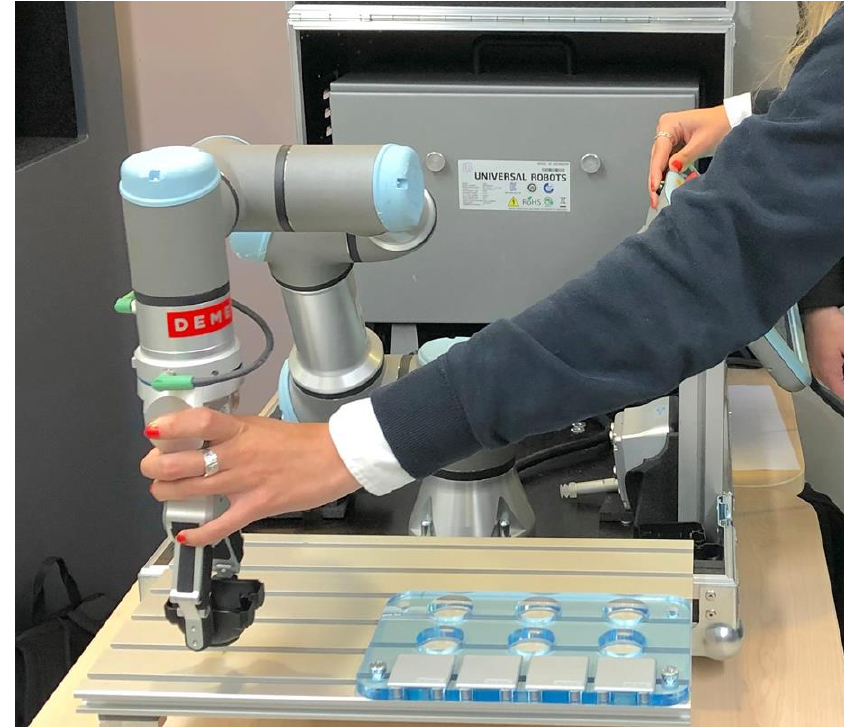
Figure 3. UR3e Collaborative Robot.